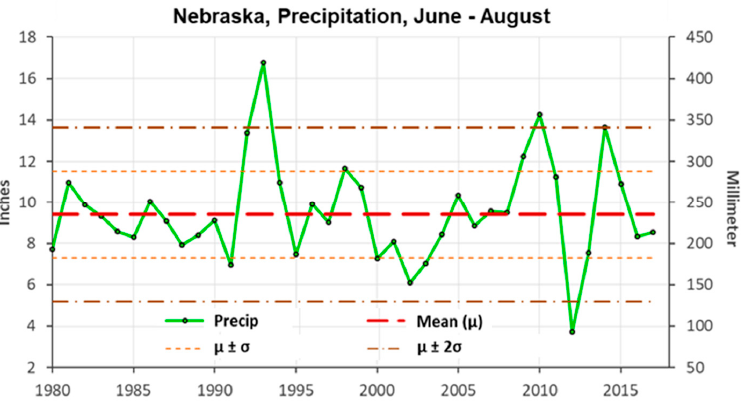
Figure 3. Nebraska precipitation average for the months of June, July, and August from 1980 to 2017; 1901–2000 mean precip ( μ : 239.3 mm); and the standard deviations ( σ : 2.11 mm) about the mean. Data source: http://www.ncdc.noaa.gov/cag/time-series/us.